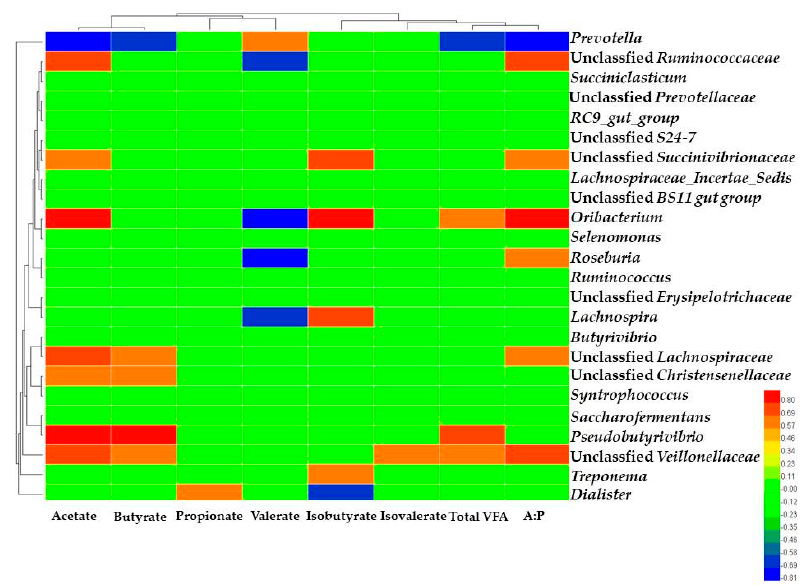
Figure 3. Heat map showing the spearman correlation between ruminal volatile fatty acids (VFA) parameters and microbiome in CON and TR groups. Red means a significant positive correlation, blue means a significant negative correlation and green means a non-significant correlation. The correlation coefficients with a statistical P value < 0.05 and the absolute value > 0.60 were used to establish the network graph. A: P = the ratio of acetate to propionate; VFA = volatile fatty acid.